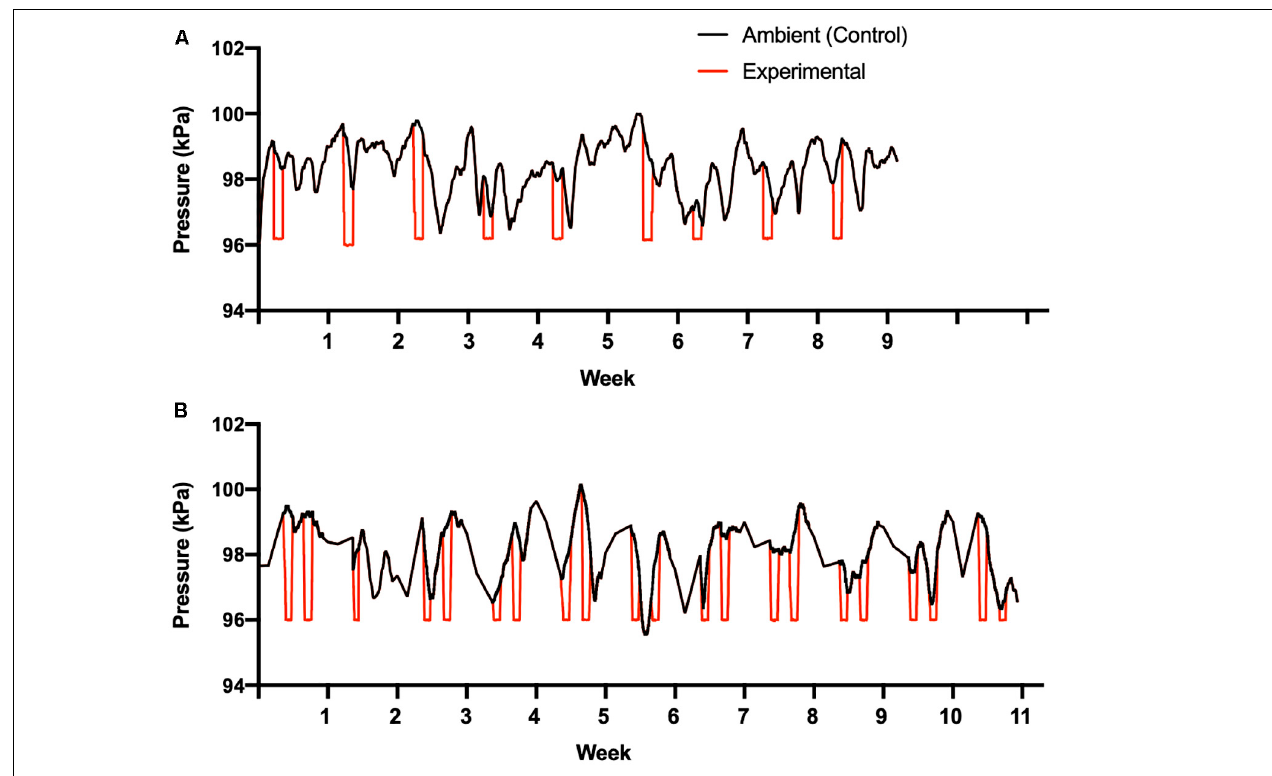
FIGURE 2 | Pressure manipulations for study 1 (A) and study 2 (B) . Black lines indicates natural changes in ambient barometric pressure during the studies, to which control birds were exposed while held at 11 ◦ C. The red lines indicates the changes in barometric pressure when experimental birds entered the wind tunnel plenum once (study 1) or twice (study 2) each week. Temperature was also decreased from 11 to 1 ◦ C for experimental birds during the times they were exposed to lowered barometric